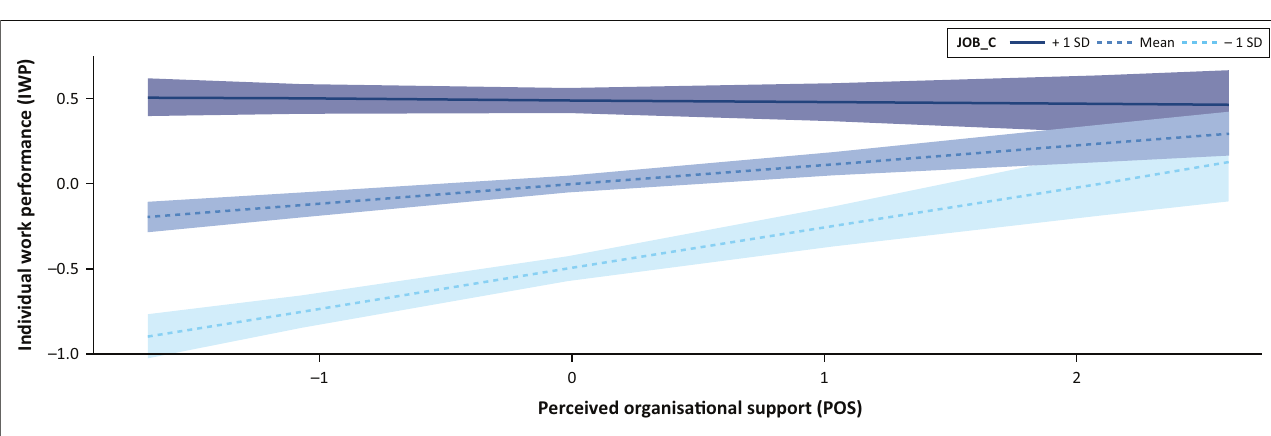
FIGURE 1: The effect of job crafting on the relationship between perceived organisational support and individual work performance.